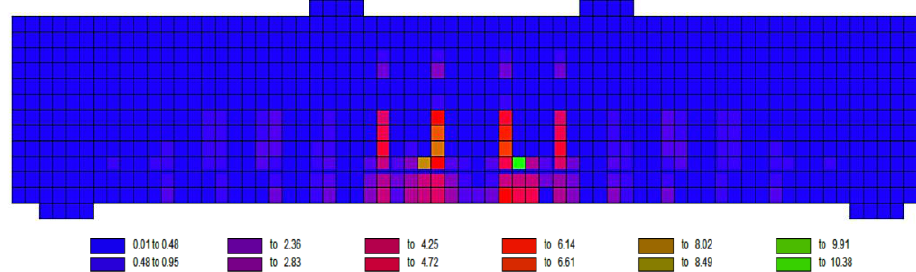
Figure 24. Numerical Crack Width (Pattern) and Failure Mode of Specimen (FB30-2).